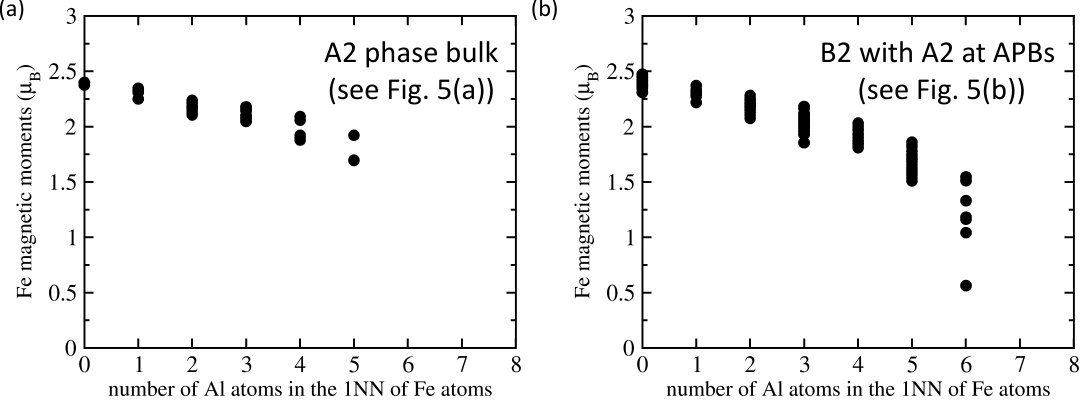
Figure 6. Calculated local magnetic moments of Fe atoms in the supercells visualized in Figure 5a,b as a function of the number of Al atoms in the 1NN. The local magnetic moments of Fe atoms in atomic configurations shown in Figure 5a,b are displayed in parts ( a , b ),